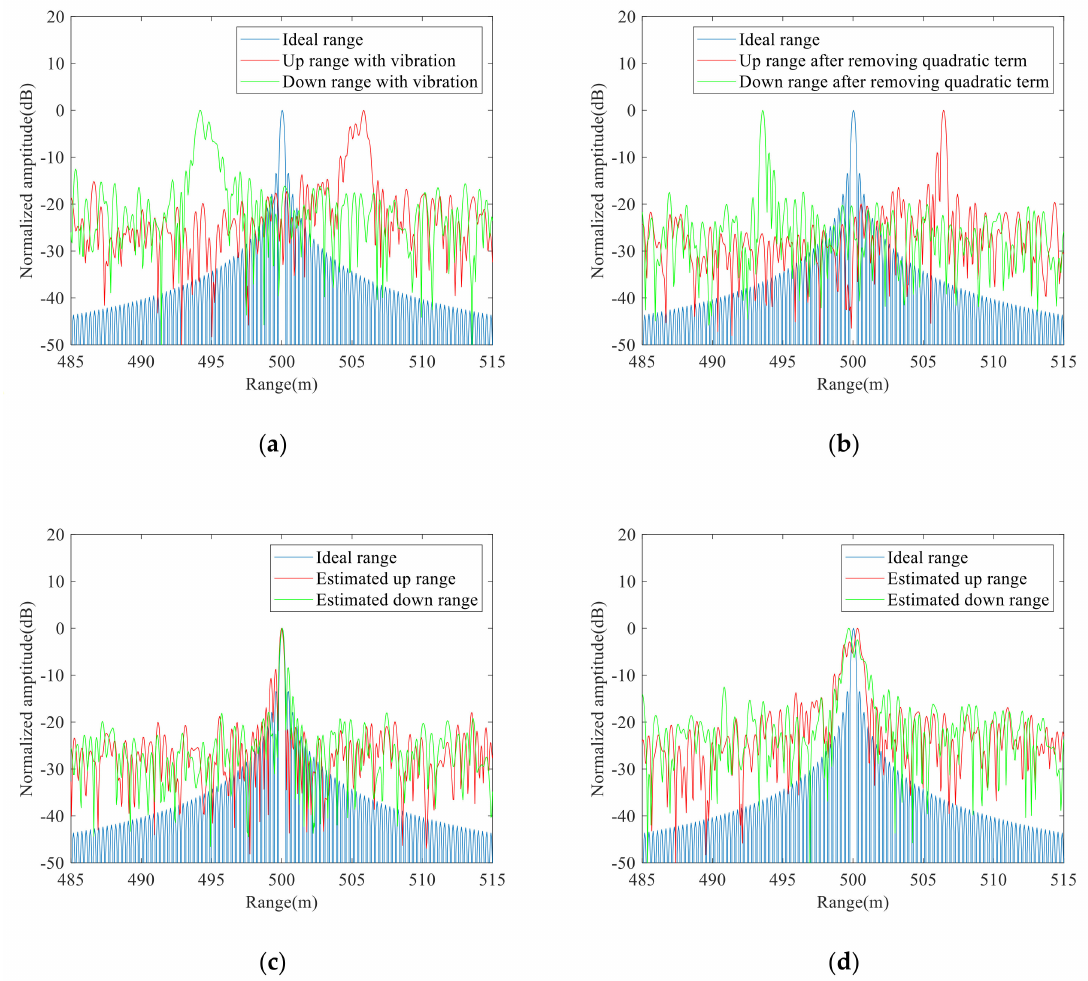
Figure 10. ( a ) One-dimensional range distributions with vibration errors; ( b ) One-dimensional range distributions after compensating for quadratic vibration errors; ( c ) One-dimensional range distributions after compensating for the primary vibration errors by using the proposed method; ( d ) One-dimensional range distributions by using the Doppler frequency shift